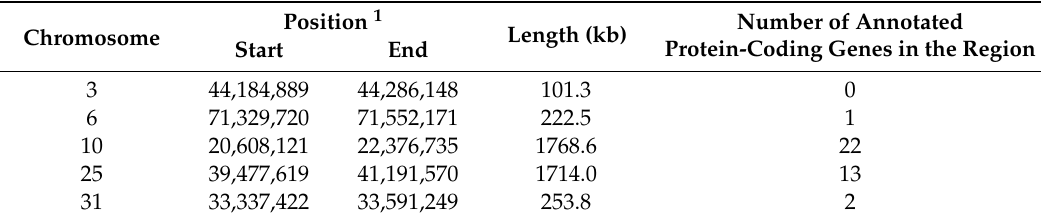
Table 1. Regions of shared homozygosity detected in four subacute necrotizing encephalomyelopathy (SNE)-a ff ected Yorkshire